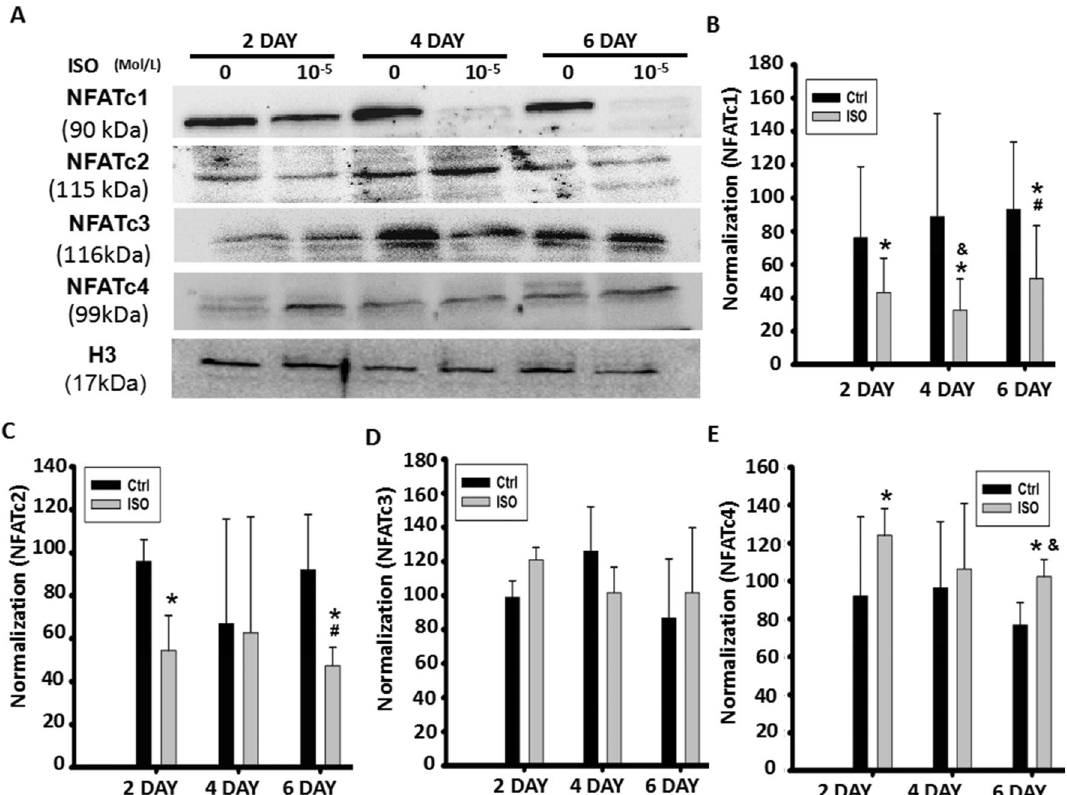
Figure 4. Continuous ISO stimulation time-dependently altered NFATc1 and NFATc2 signaling. ( A ) Continuous ISO stimulation reduced nuclear levels of NFATc1 and NFATc2 while slightly increasing nuclear levels of NFATc3 and NFATc4, as determined by western blot, 2, 4 and 6 days after myoblast differentiation following the stimulation of ISO delivered with a continuous single dose. ( B – E ) Semi-quantitative assay from Fig. 3A. Three independently repeated experiments were performed. n = 3, *P < 0.05 versus Ctrl at the indicated times ; & P < 0.05 versus the 10 −5 M ISO group on the second day of myoblast differentiation; # P < 0.05 versus the 10 −5 M ISO group on the 4th day of myoblast